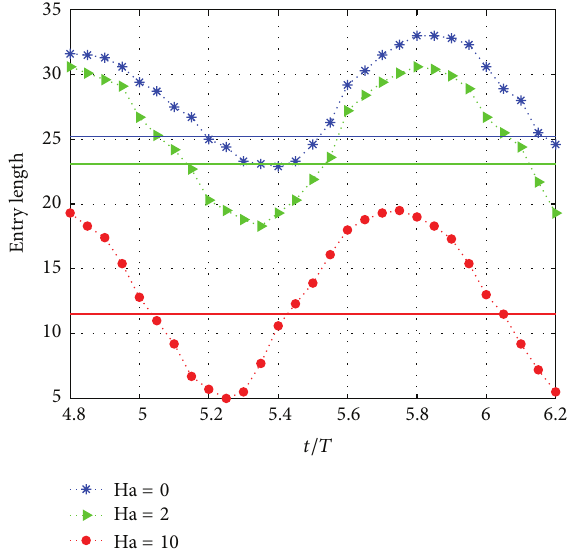
Figure 8: Unsteady entrance length with time for different Hart- mann number Ha, when Re = 100 and 𝛼 = 5 . (Solid lines represent the corresponding steady entrance